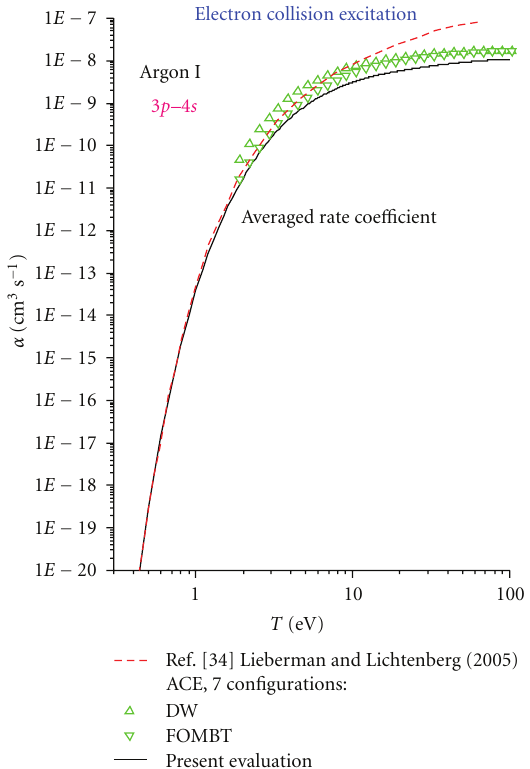
Figure 6: Averaged electron excitation rate coe ffi cient of Ar I 3 p –4 s from 0.3 to 100